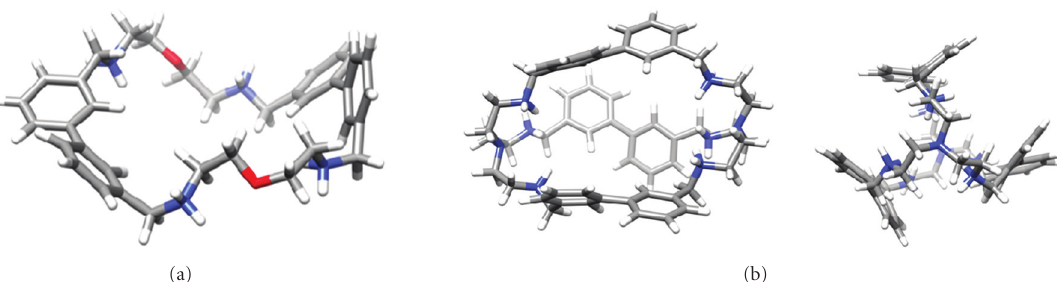
Figure 5: Lowest energy conformations of (a) 3,3 (cid:3) -BisBP and (b) 3,3 (cid:3) -TrisBP (front and side-view) during a molecular dynamic simulation in a water box